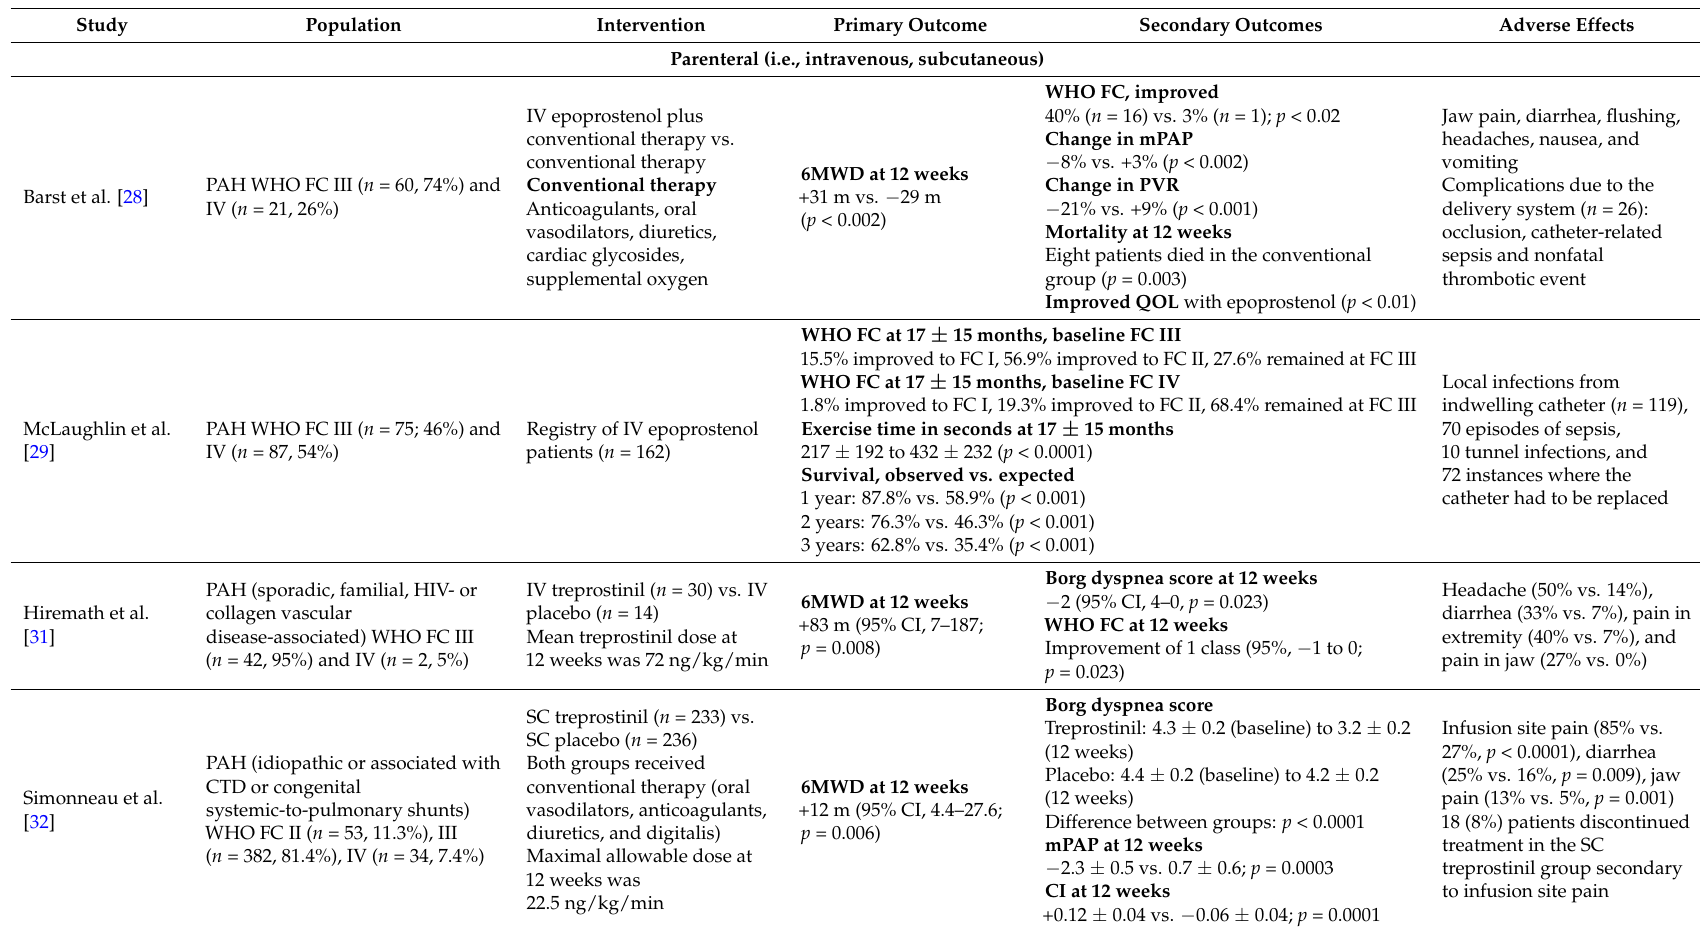
Table 4. Prostacyclin Clinical